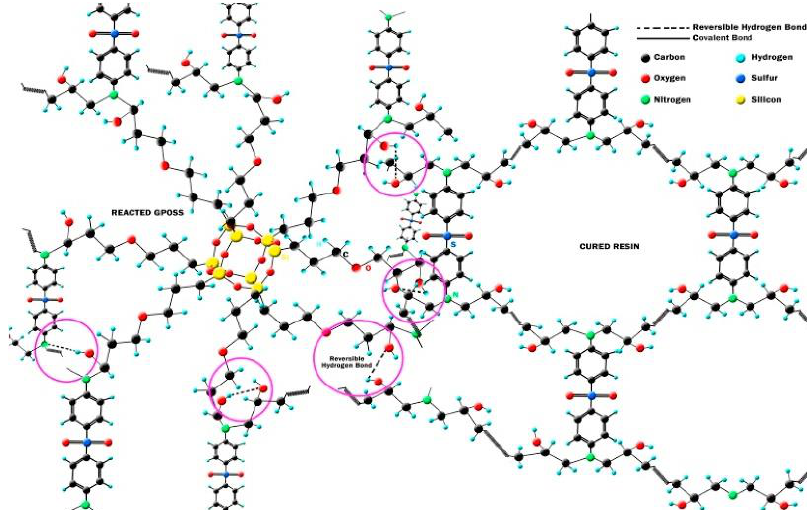
Figure 2. Self-healing mechanisms based on reversible hydrogen bonds in a phase separated epoxy resin containing POSS and MWCNT. Reprinted from Composites Part B, 2017, 128; Guadagno, L.; Naddeo, C.; Raimondo, M.; Barra, G.; Vertuccio, L.; Sorrentino, A.; Binder, W.H.; Kadlec, M., Development of self-healing multifunctional materials, 30–38. Ref. [54] Copyright (2017), with permission from Elsevier.